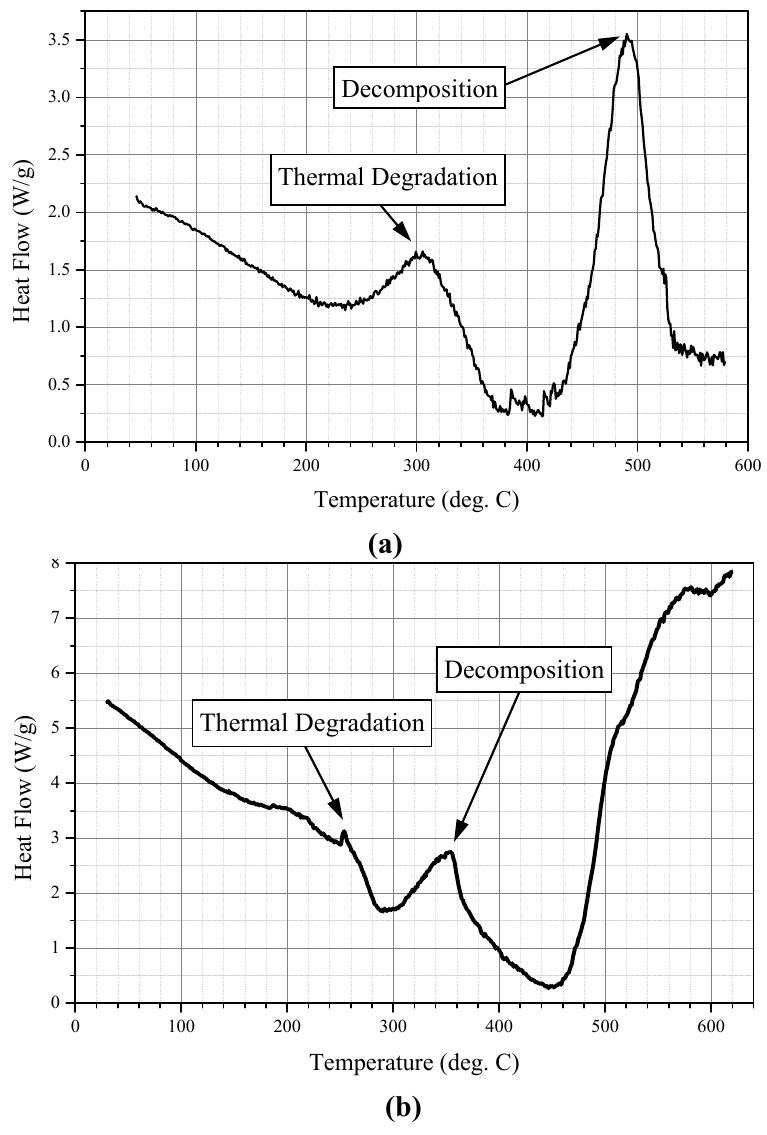
Figure 2. (a) Thermogram of ABS powder with 60% PB after isothermal test. (b) Thermogram of SAN copolymer